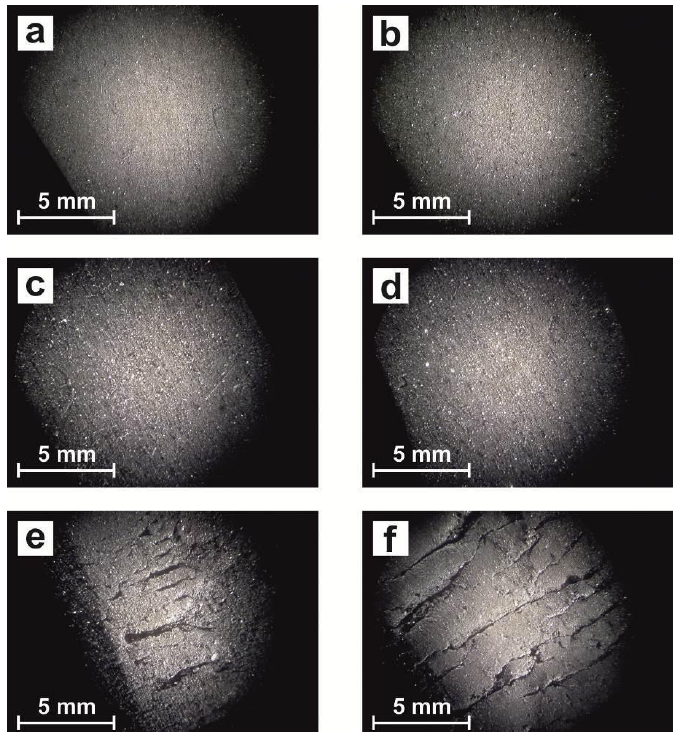
Figure 2. Stereoscopic loupe micrograph of surface of SEBS: ( a ) without exposure (T0), ( b ) UV exposure T1, ( c ) UV exposure T3, ( d ) UV exposure T5, ( e ) UV exposure T7, and ( f ) UV exposure T9.